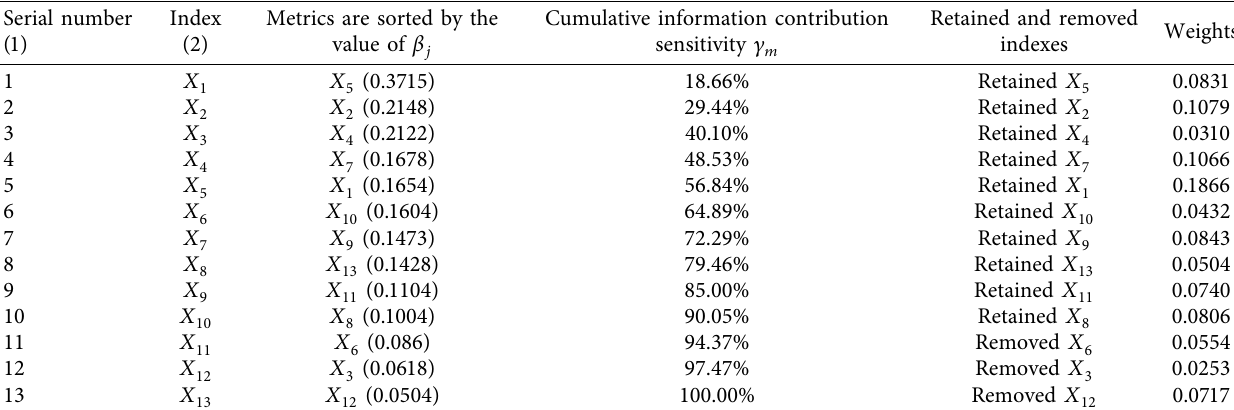
Table 5: Index screening and weighting based on cumulative information contribution